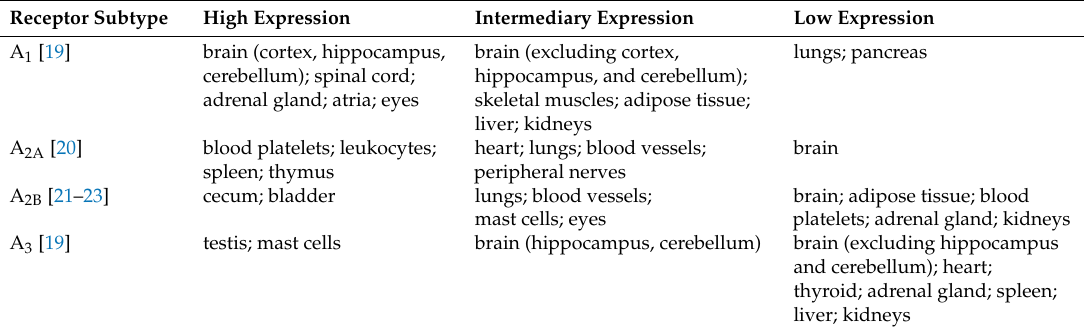
Table 1. Adenosine receptors (AR) receptor distribution and expression in di ff erent tissue